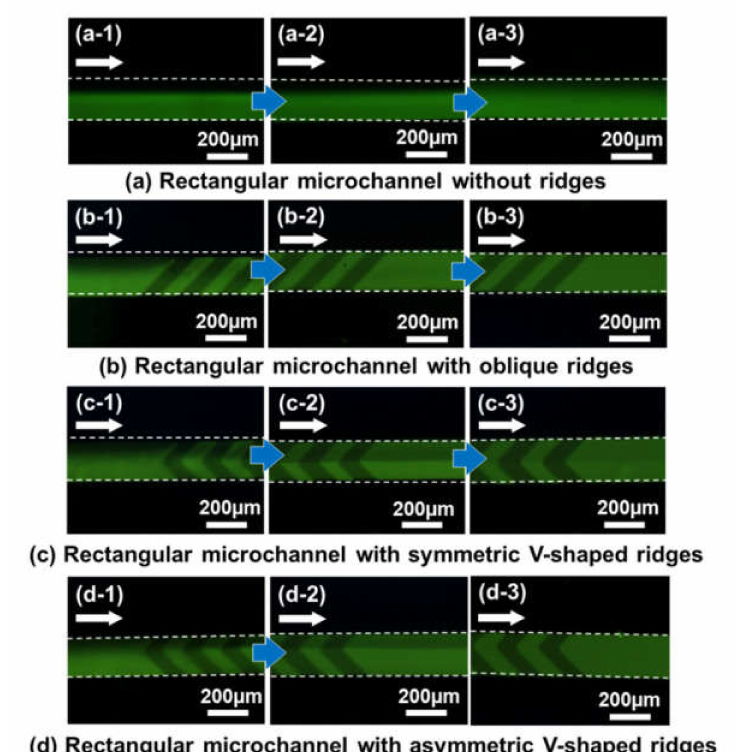
Figure 8. Experimental results showing fluorescence microscopy images (taken with an optical filter B-2A, gain: 1 × , exposure time: 2 s) of the mixing process in ( a ) a rectangular microchannel without ridges, and ( b ) a chaotic mixer with oblique ridges, ( c ) symmetric V-shaped ridges, and ( d ) asymmetric V-shaped ridges. Fluorescein-dyed water (1 mM) and pure water were introduced at the same flow rate of 5 µ L /